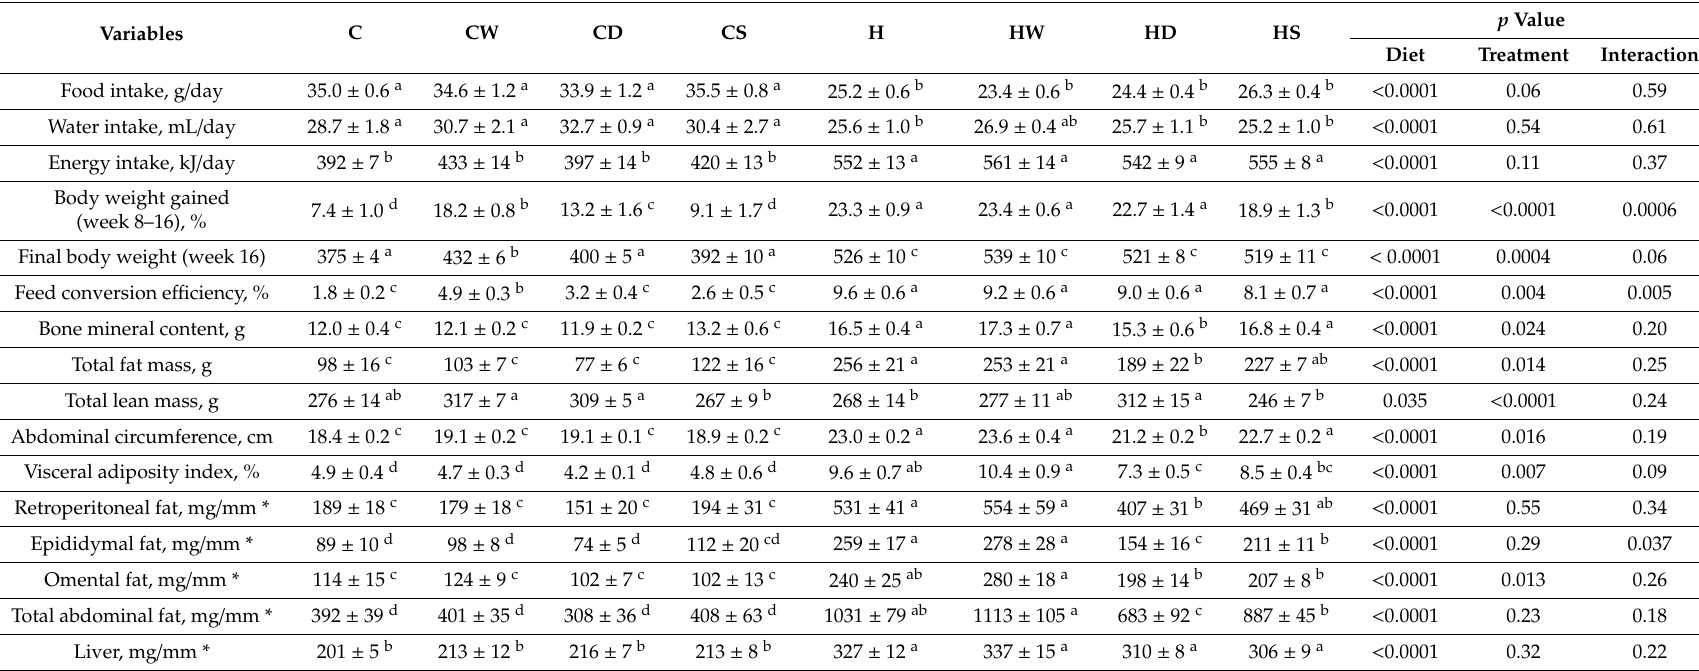
Table 1. Dietary intakes, body composition, and organ wet